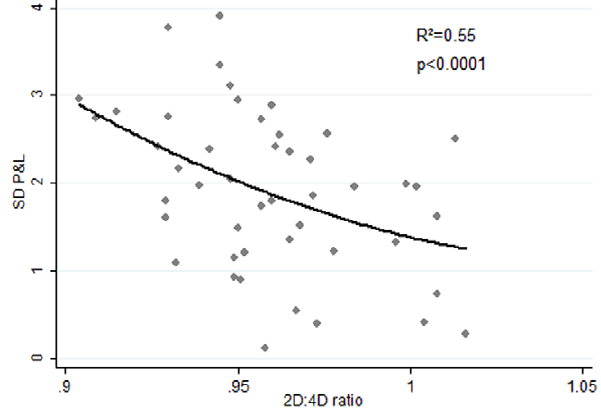
Figure 3. 2D:4D vs risk. Traders’ 2D:4D ratios plotted against their risk, i.e., standard deviation of their P&L, Box-Cox transformed. The fitted curve is quadratic. N=53.